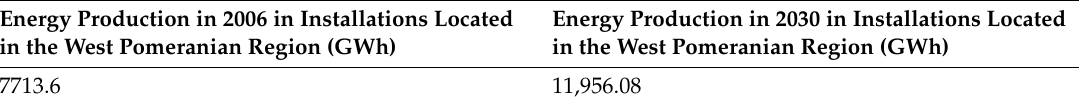
Table 5. Electricity production forecast for the area under investigation until 2030.